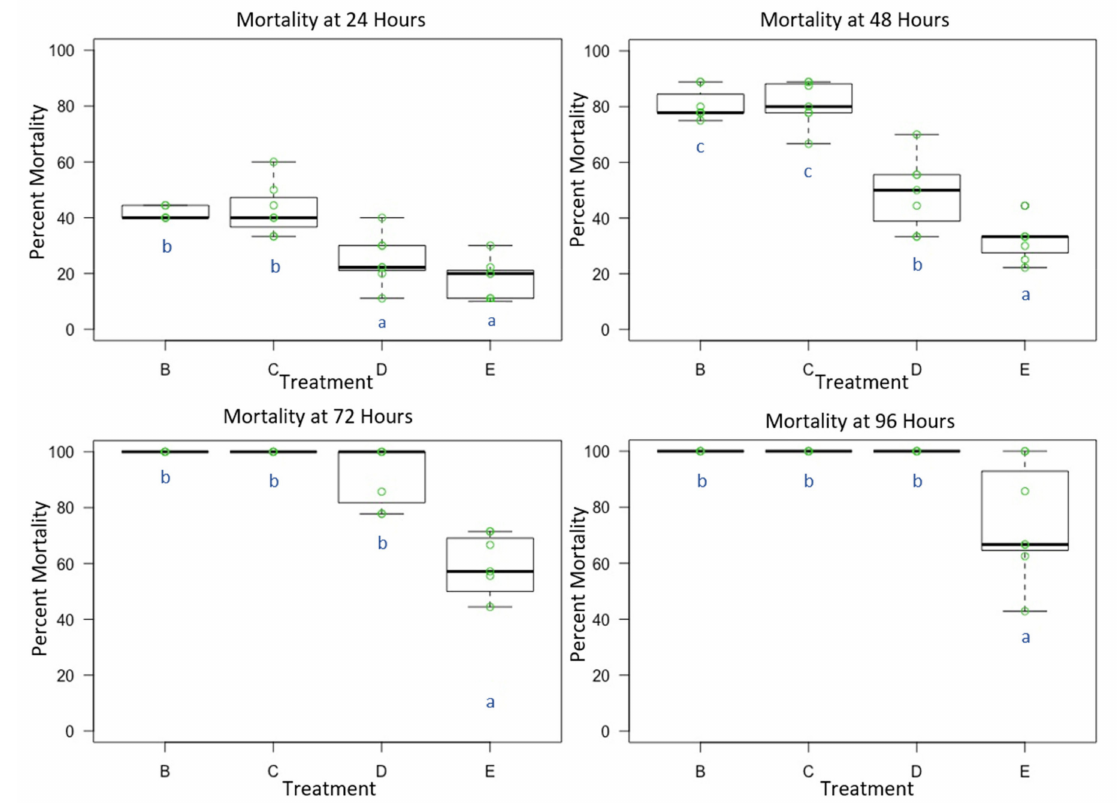
Figure 1. Male Osmia lignaria Acute Contact Toxicity Following Whole-Body Contact Exposure to Premix Insecticides: Male Osmia lignaria mean, 1st and 3rd quartile percent mortality following whole-body contact exposure to each insecticide mixture (Experiment 1) at 24, 48, 72 and 96 h. Data on the x-axis indicate each insecticide treatment, and data on the y-axis indicate percent mortality. Insecticide treatments: B = TLC, C = IBC, D = CLC, E = MS. All jars in a treatment containing the respective percent mortality are represented by a single green point. Letters (a, b, c) indicate significant difference at p < 0.05 (pairwise comparison). Information related to control mortality is given in the result